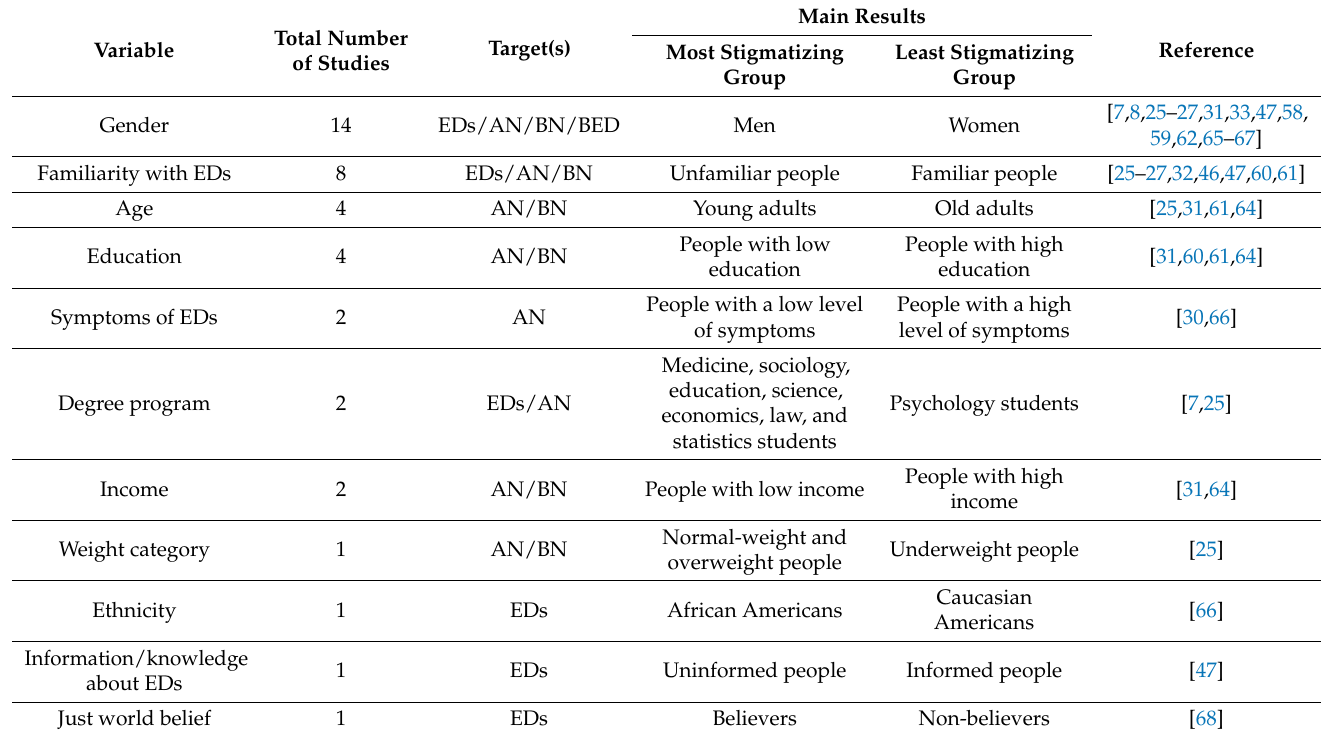
Table 2. Distribution of ED